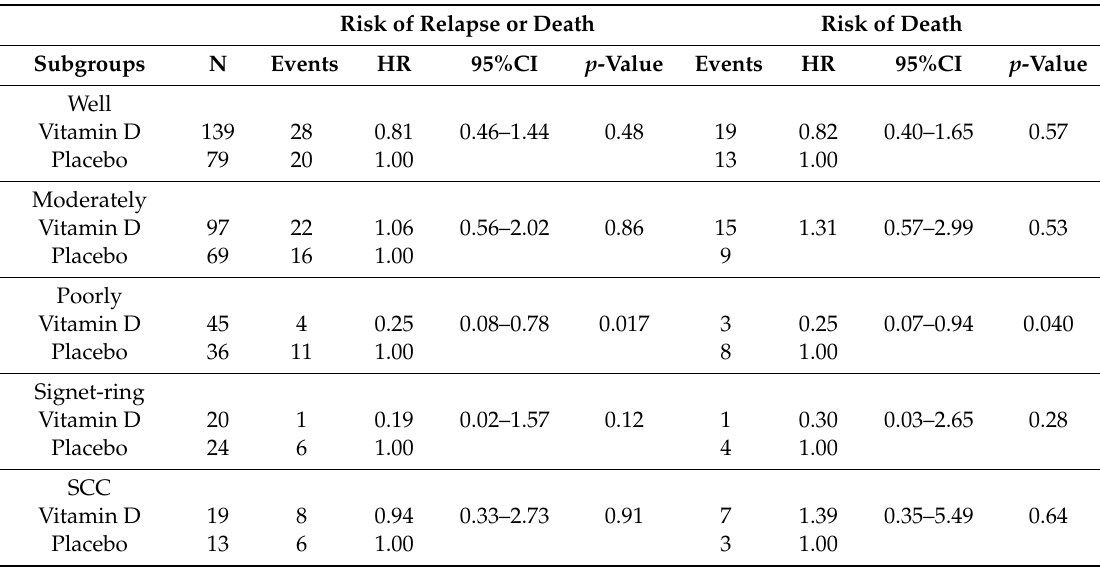
Table 2. E ff ect of Vitamin D supplementation on risk of relapse or death and death in subgroups stratified by histopathological